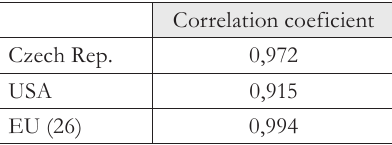
Tab. 7 - Correlation between tertiary education graduates and researchers. Source: (Eurostat, 2013a), (Eurostat, 2013b), own processing.